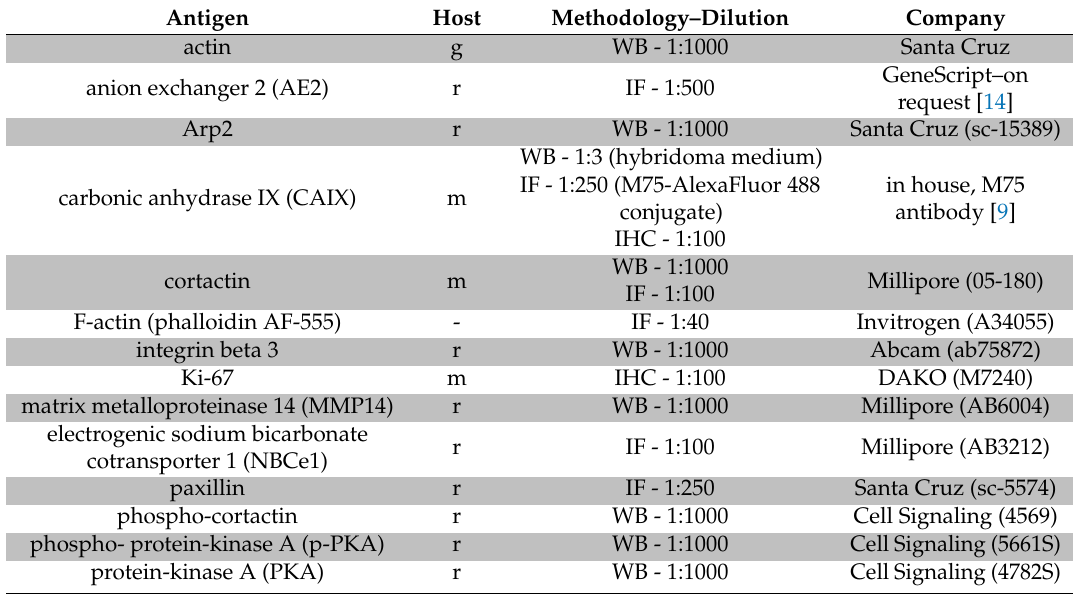
Table 1. List of primary